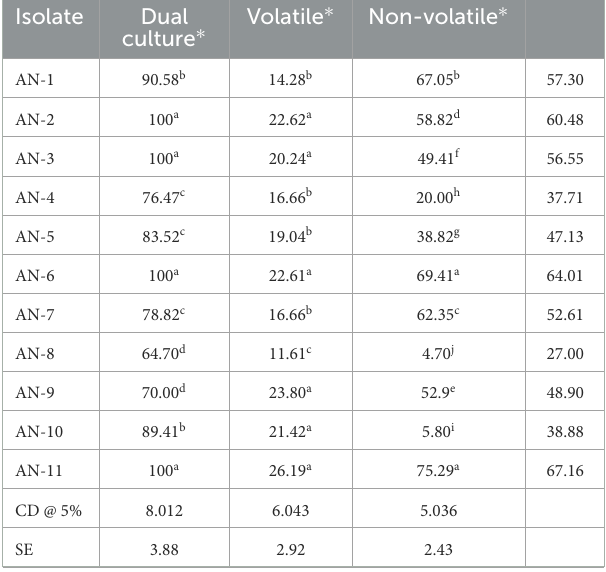
TABLE 2 Inhibition of mycelial growth of F. oxysporum f. sp. psidii by A. niger strains under in vitro